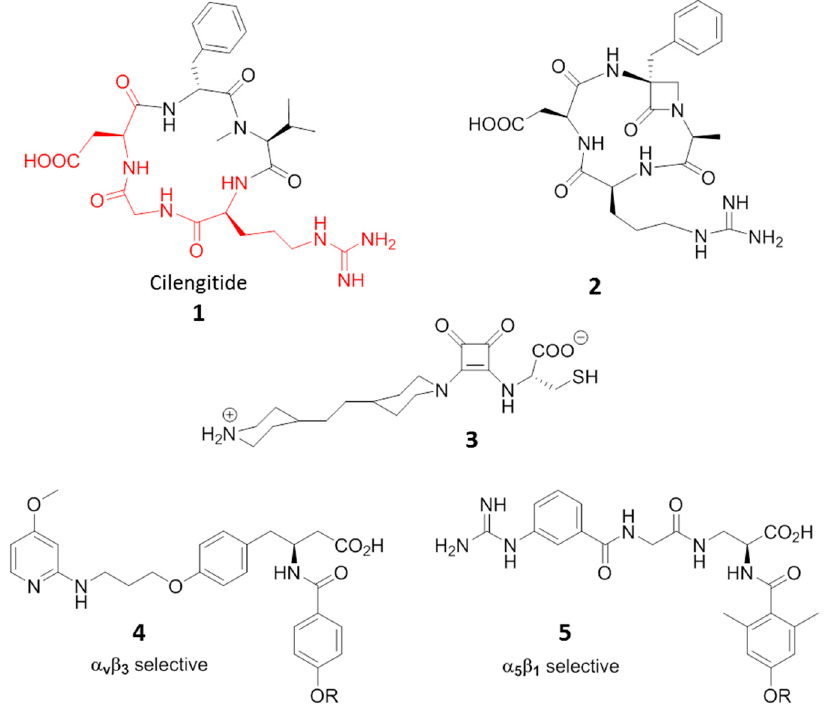
Figure 4. Ligands to RGD-binding integrins displaying agonist behaviour. RGD sequence in Cilengitide is highlighted in red.